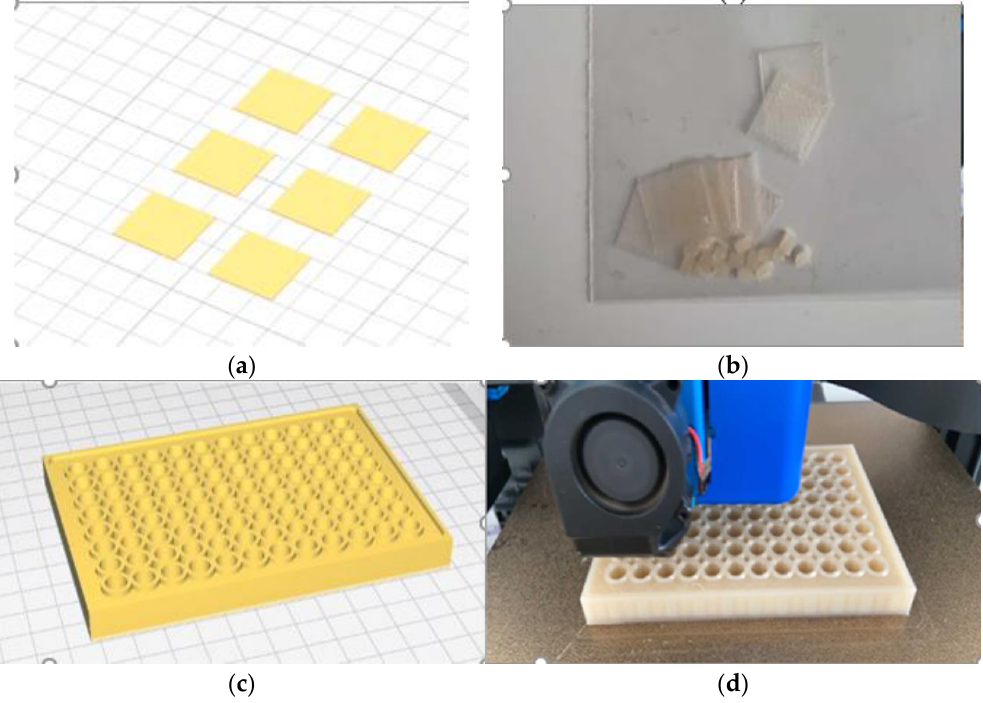
Figure 2. Sheets and microtiter plate; 3D printed. ( a ) STL file of sheets ( b ) Printed sheets ( c ) Microtiter plate STL file ( d ) Printed microtiter plate.